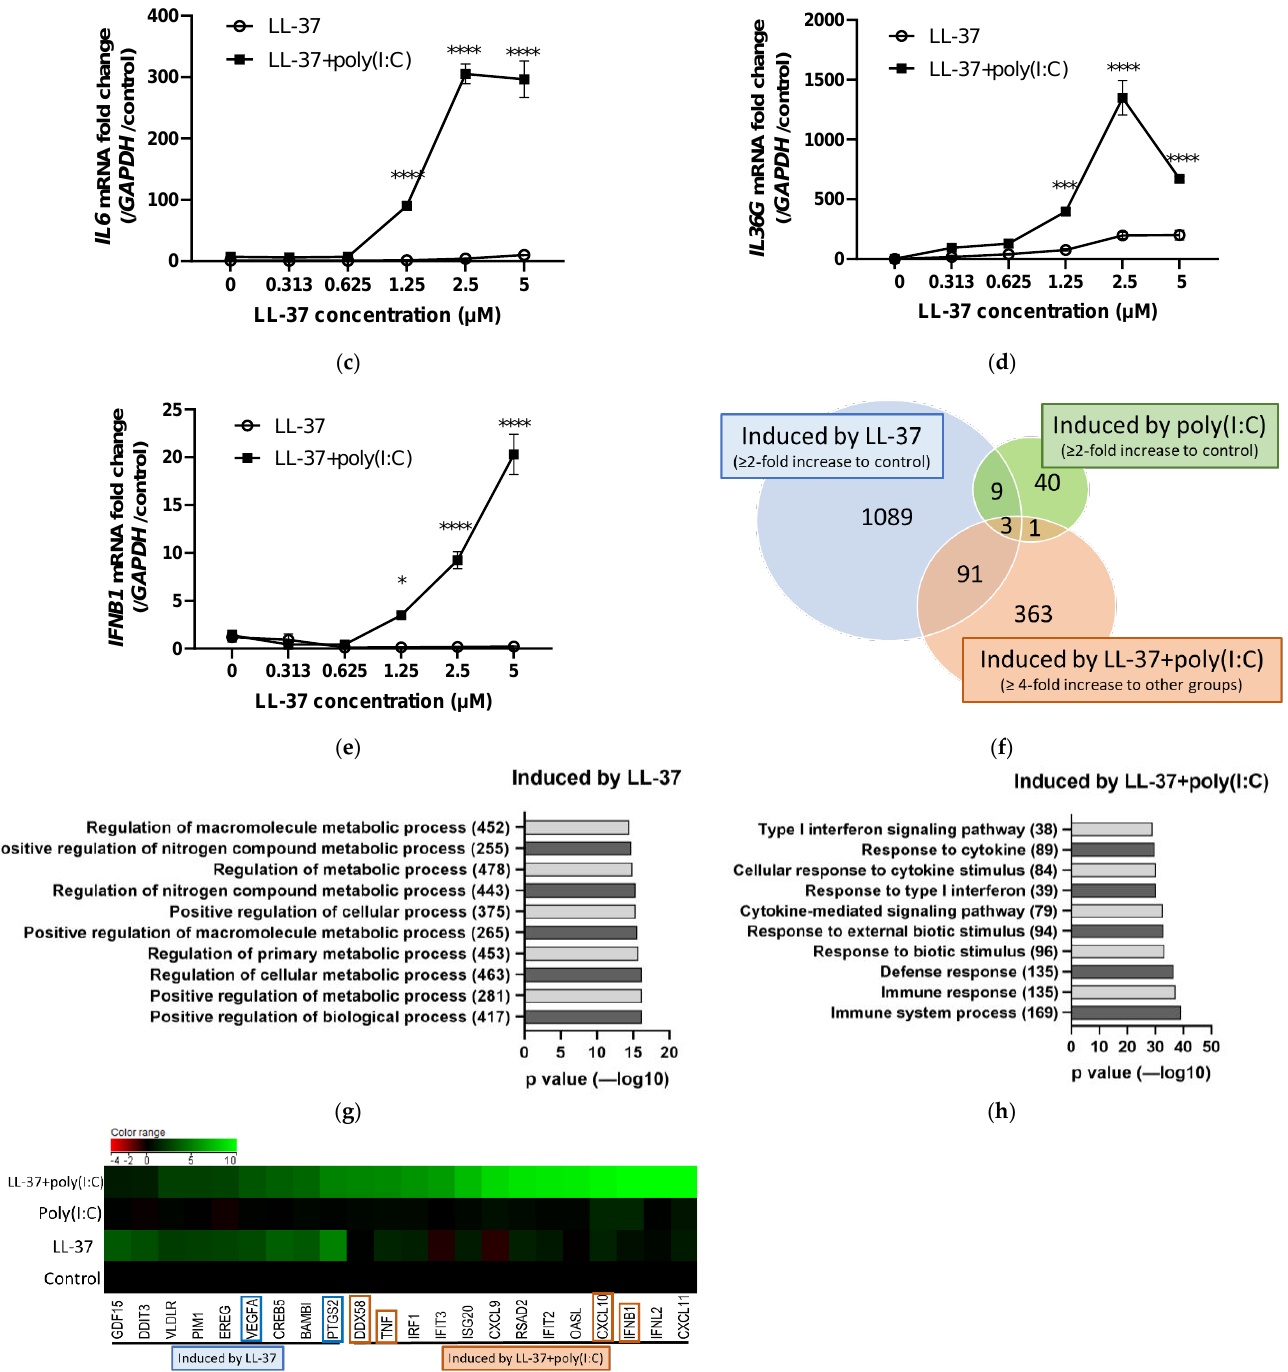
Figure 1. DNA microarray revealed that LL-37 alone induced biological and metabolic processes, while the combination of LL-37 and poly(I:C) induced immune responses in keratinocytes. ( a ) Poly(I:C) (0.3 μ g/mL), CpG ODN (14.1 μ g/mL) or ( b ) poly(dA:dT) (1 μ g/mL) with LL-37 (2.5 μ M) each alone or in combination were added to NHEK and cultured for 6 h. The induction of IL6 mRNA was measured by RT-PCR. NHEKs were stimulated with LL-37 at different concentrations (0.313 – 5 μ M) alone or in combination with poly(I:C). RT-PCR was performed to quantify the mRNA expressions of ( c ) IL6 , ( d ) IL36G , and ( e ) IFNB1 . NHEKs were stimulated with LL-37 and poly(I:C) alone or in combination and analyzed by DNA microarray. ( f ) A Venn diagram shows the number of genes upregulated by each stimulation. Blue: LL-37, green: poly(I:C), red: LL-37+poly(I:C). Gene ontology analyses of genes induced when stimulated with ( g ) LL-37 alone or ( h ) in combination